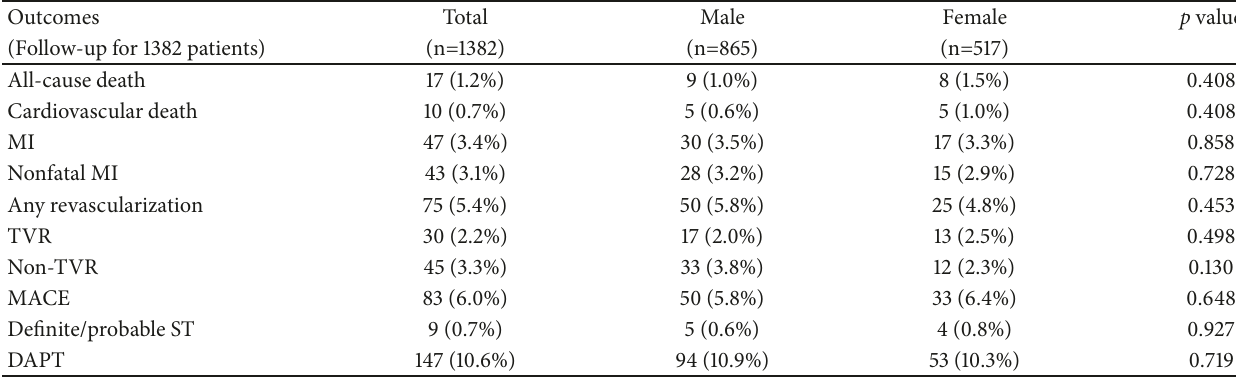
Table 4: Clinical outcomes comparing male and female for 36 months.